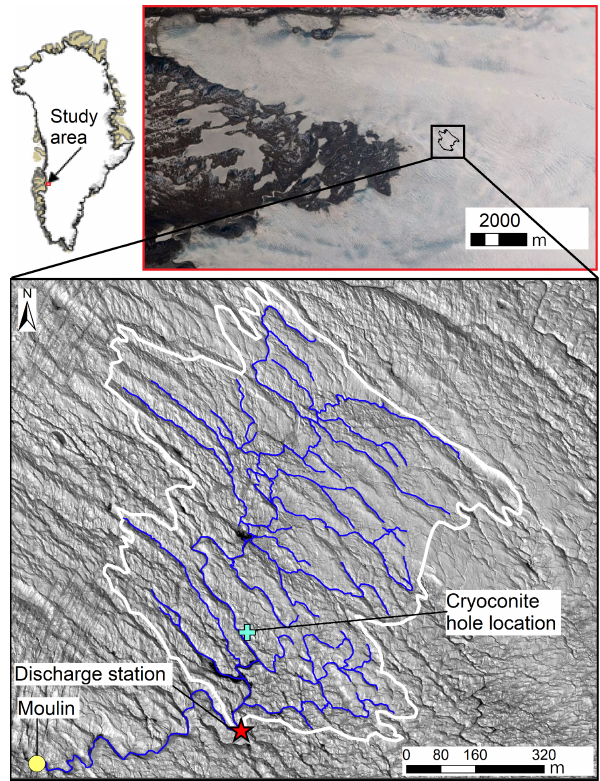
Figure 1. Map of the study site showing the supraglacial catchment boundary (white); streams of order 1, 2, and 3 (blue); and locations of the discharge station, cryoconite hole, and terminal